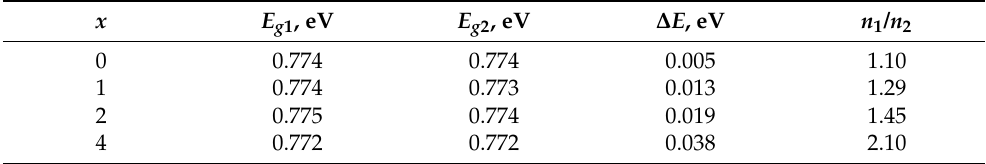
Table 1. Band gap and change in the position of the impurity band and the conduction band population in CNT(10,0)/ZnPc- x py hybrids with the addition of four ammonia molecules. x E g 1 , eV E g 2 , eV ∆ E , eV n 1 / n 2 0 0.774